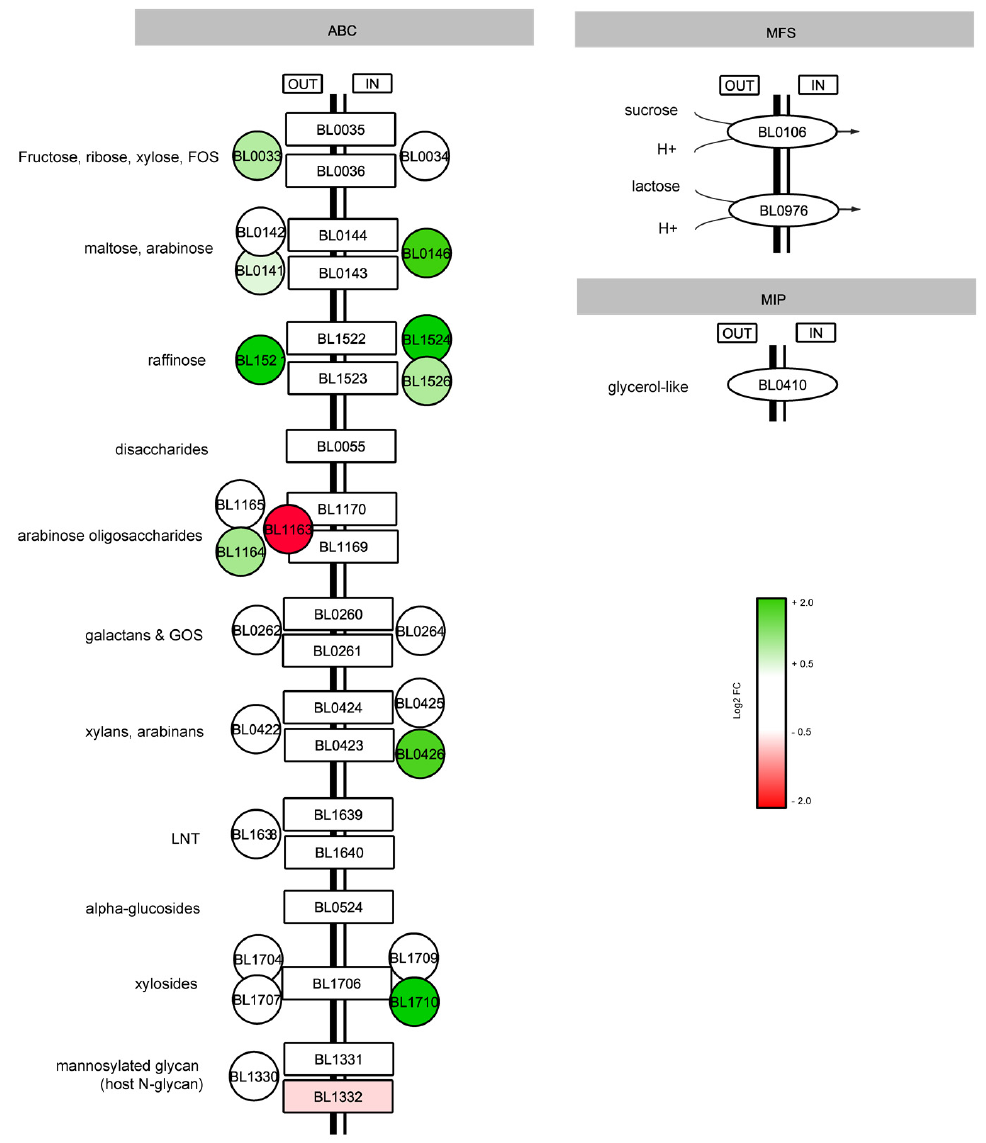
Figure 5. Differential expression of genes related to carbohydrate transport in B. longum NCC 2705 grown on galactose or glucose. Fold expression change in galactose growth induced (green) and glucose growth induced genes (red) are displayed in log2 scale.